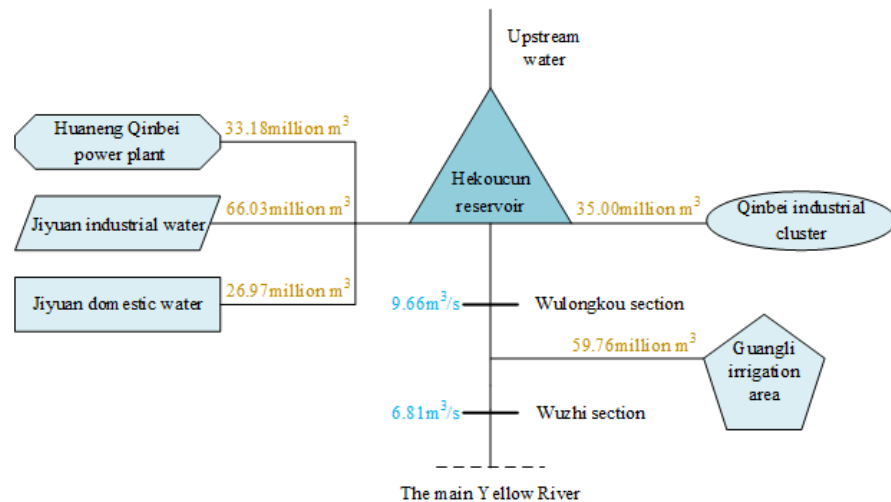
Figure 3. Distribution diagram of water users. Table 1. Water demand allocation scheme of Hekoucun reservoir in 2030 (million m 3 ).